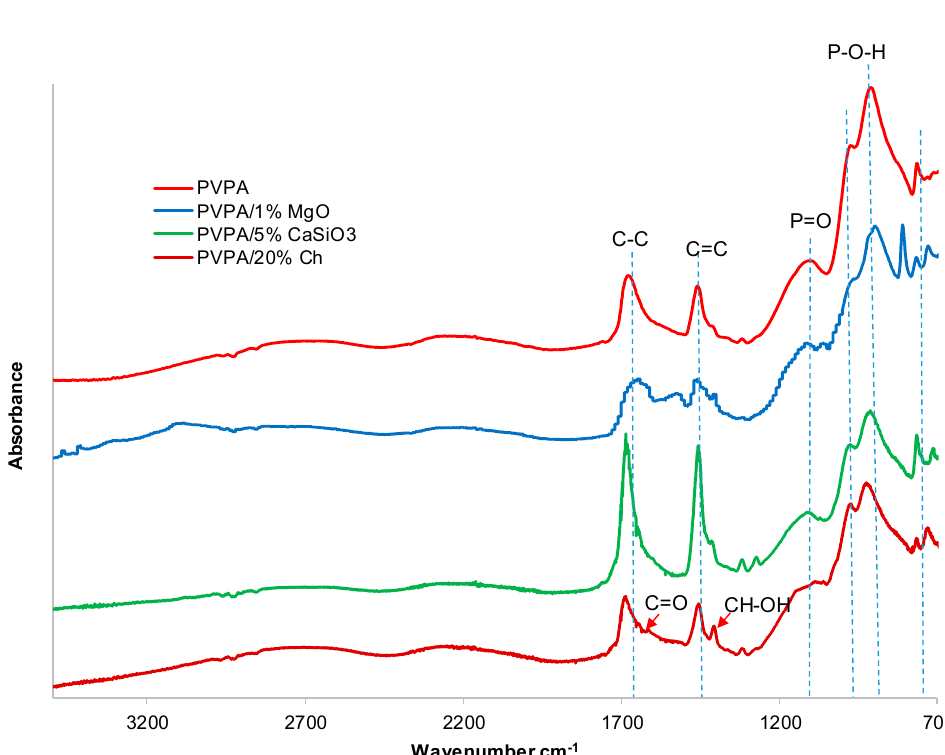
Figure 3. FTIR spectra of poly(vinylphosphonic acid) PVPA, PVPA/1% MgO, PVPA/5% CaSiO 3 , and PVPA/20% Chitosan (Ch).